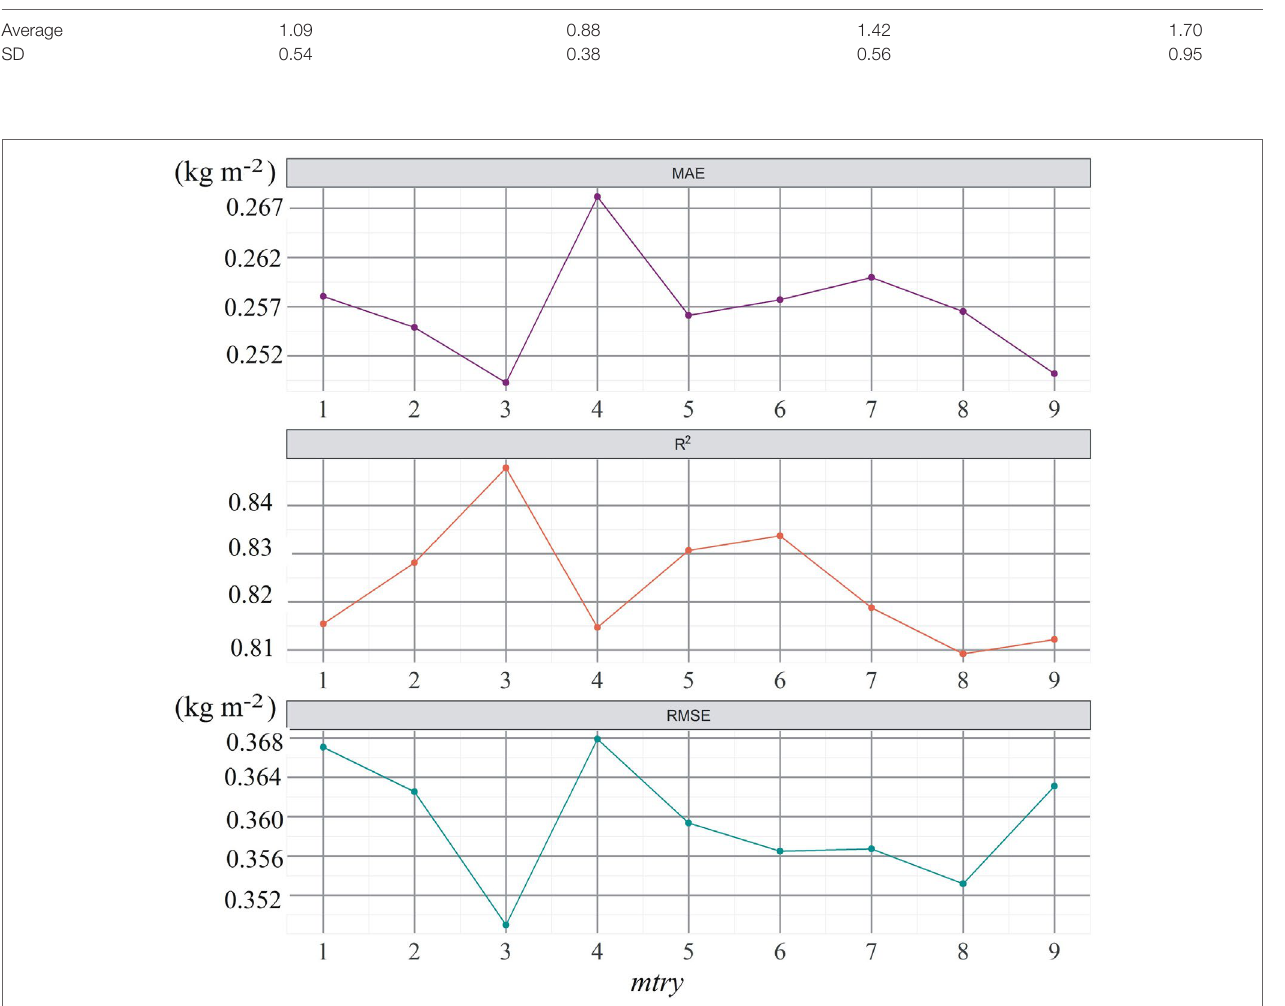
model for use in predicting AGB in the Poyang Lake wetlands.